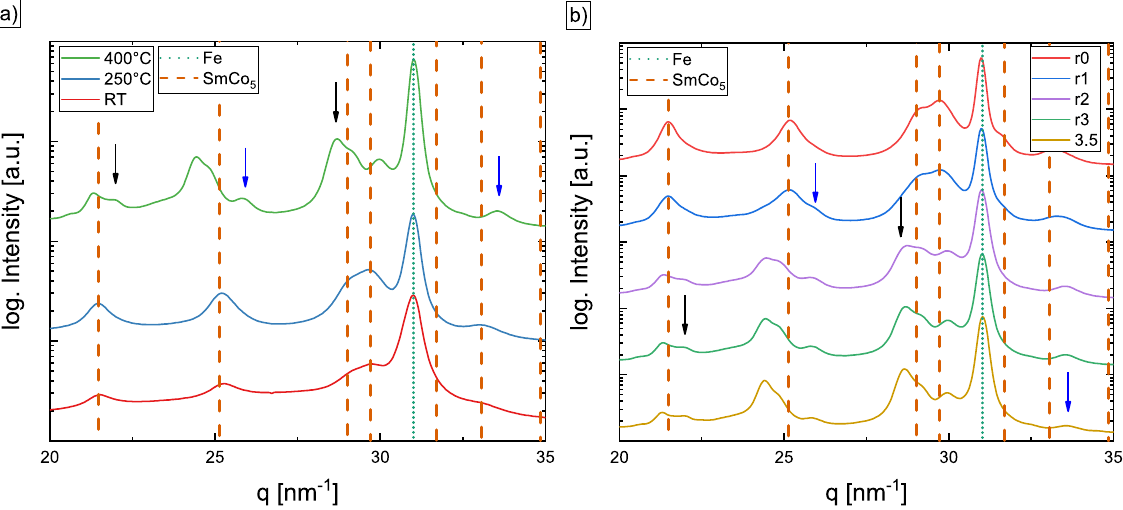
Figure 5. Synchrotron XRD measurements of several Fe-47 wt.% samples deformed at different temperatures at r3 ( a ) and for the sample deformed at 400 ◦ C as a function of the radius ( b ). Examples of peak positions of the Sm 2 Co 7 (black) and Sm 2 Co 17 (blue) are indicated by